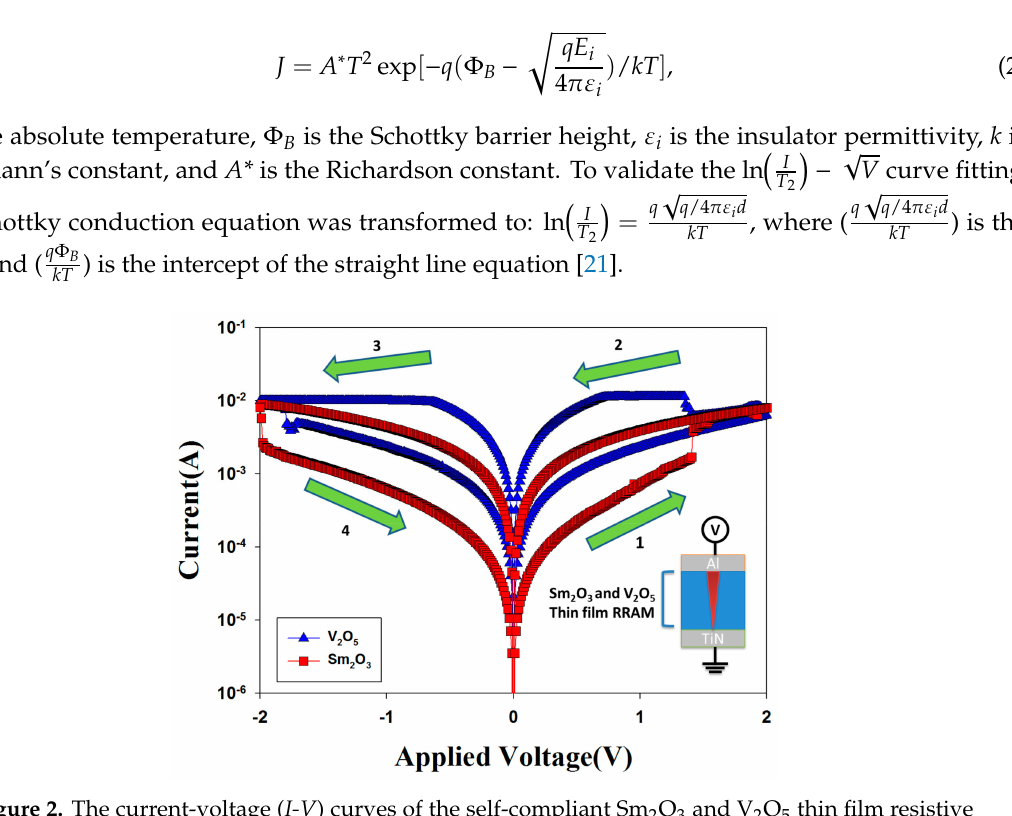
Figure 2. The current-voltage ( I-V ) curves of the self-compliant Sm 2 O 3 and V 2 O 5 thin film resistive random access memory (RRAM) structure devices during the set / reset